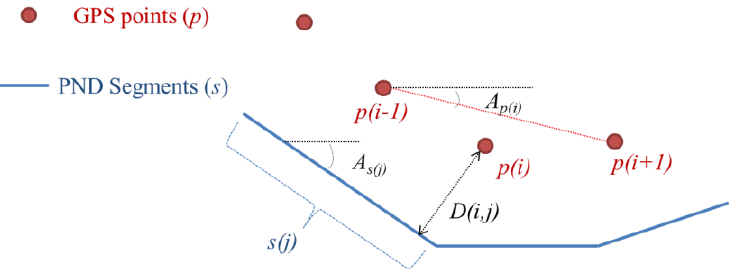
Figure 3. Evaluation of the distance ( D ) and the direction ( A ) conditions between GPS trajectory and